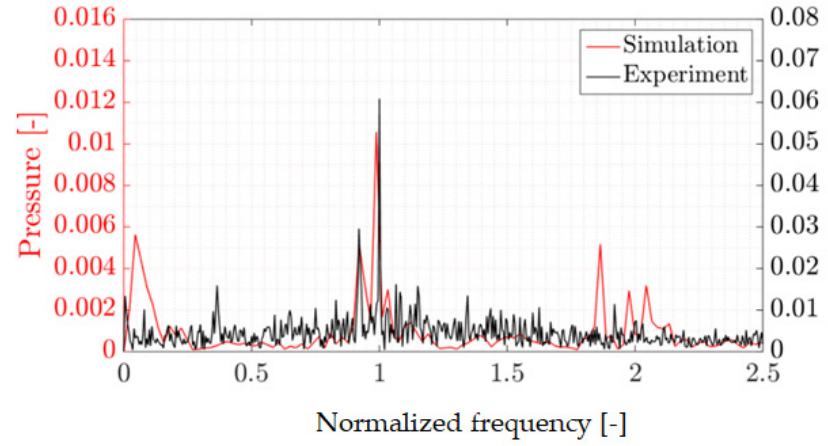
Figure 13. Amplitude spectrum of the pressure at P-PS-3 (pressure side, near the trailing edge). Two vertical axes are used; numerical results—red, experimental results—black.